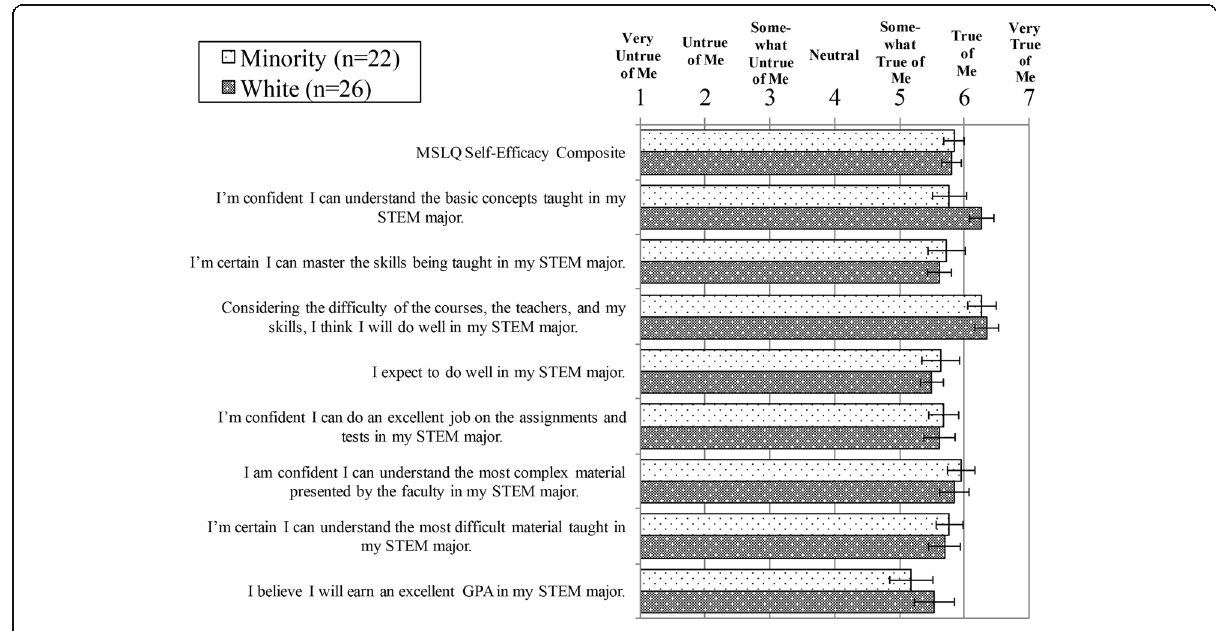
Fig. 7 MSLQ: self-efficacy for learning and performance motivation sub-scale (Pintrich et al. 1991)